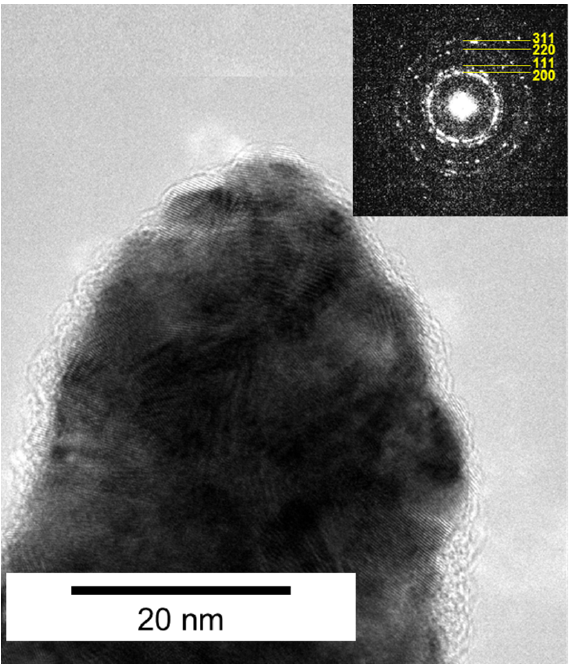
Figure 7. EDX spectrum of the obtained platinum cones. The arrows indicate the platinum signals observed at 9.42 keV (Lα line), 2.04 keV (Mα + Mβ line) and 1.59 keV (Mξ line).